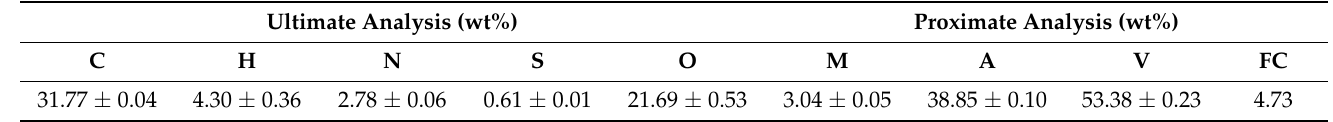
Table 1. Ultimate analysis and proximate analysis of the sewage sludge.